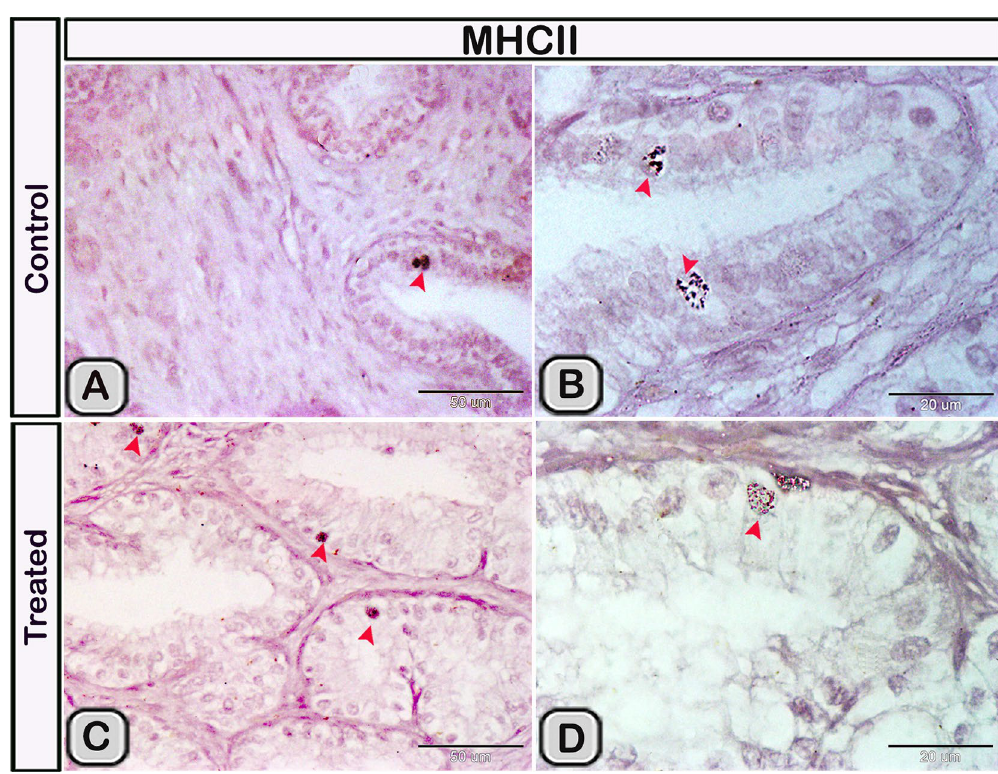
Figure 9. The effect of melatonin administration on the expression of MHC-II in the DCs. (A,B) The endosomal compartments of the dendritic cells showed positive immunoreactivity for MHC-II. (C,D) Expression of the MHCII in the endosomal compartments of the DCs was more abundant after melatonin administration (red